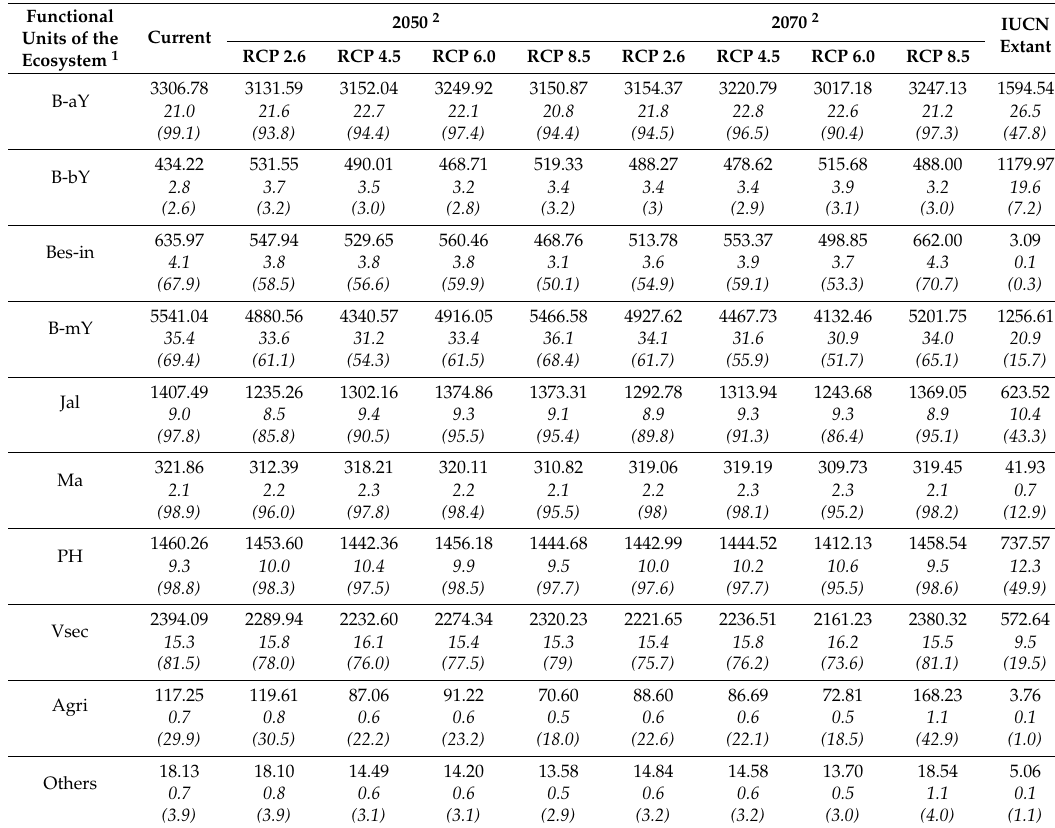
Table 5. Area (in km 2 and %) of the total potential distribution predicted both in current conditions and in climate change scenarios of the spectacled bear according to the functional unit of the ecosystem it encompasses in Amazonas